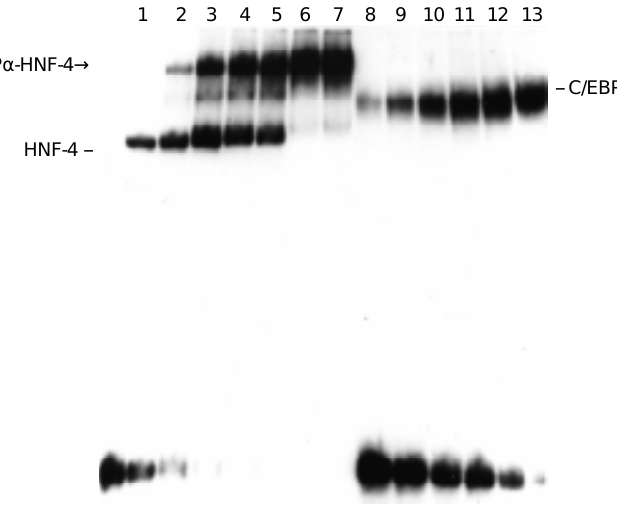
Figure 1 - Synergistic effect of C/EBP a and HNF-4 in the apoB promoter. Transcription factors HNF-4 and C/EBP a were purified by affinity chromatogra- phy. The transcription factors were incubated with 32 P-labeled double-stranded wild type oligonucle- otides (5’-AGGCGCCCTTTGGACCTTTTGCAATCC